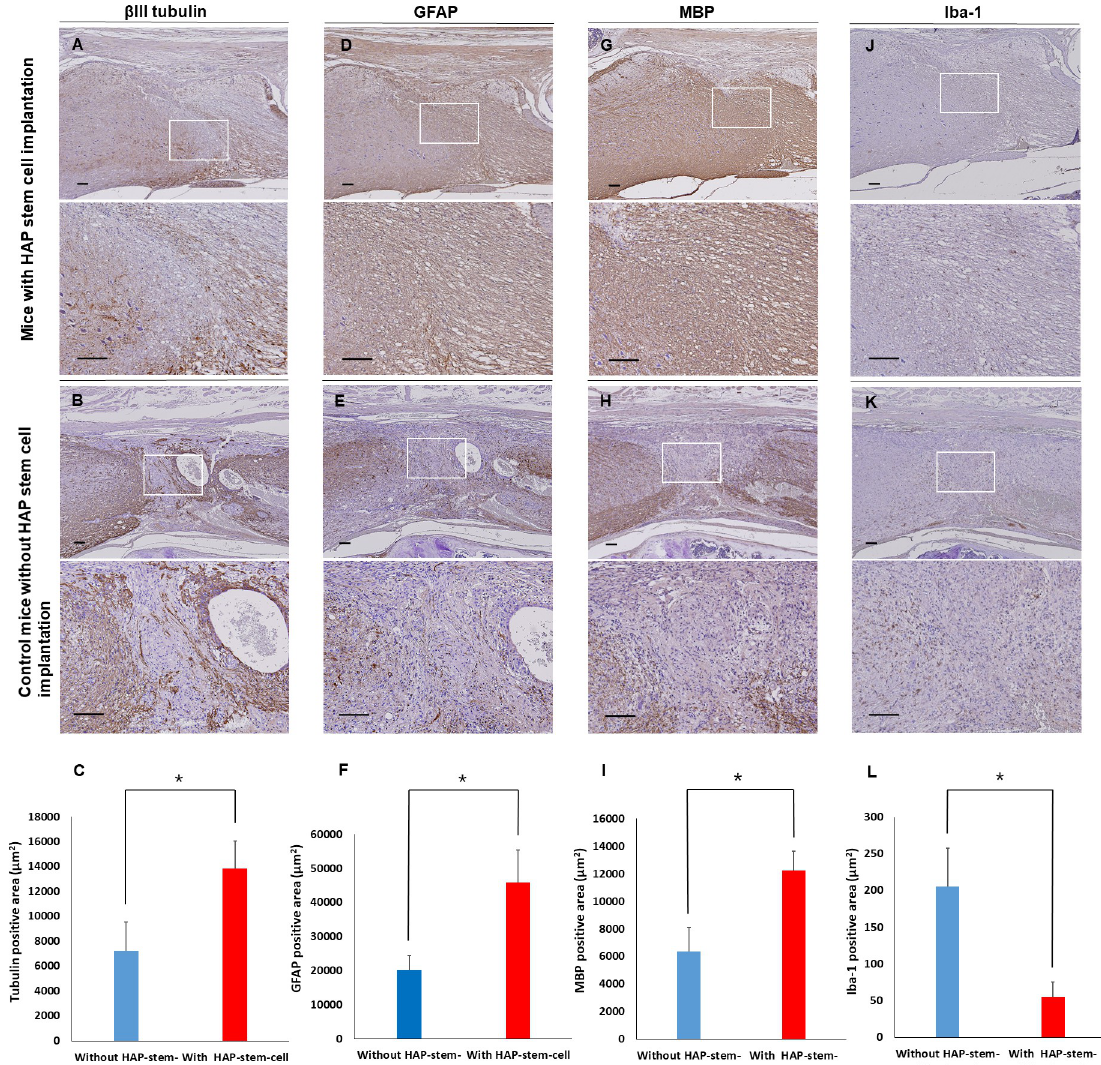
Fig 5. Immunostaining of the severed spinal cord implanted with HAP stem cells. (A, B) β III tubulin expression in the repaired spinal cord after HAP-stem-cell implantation and without implantation. (C) The β III tubulin-positive area in sagittal sections in mice with implanted HAP stem cells and control mice (mice with HAP-stem-cell implantation: n = 5; control mice without implantation: n = 5). � P < 0.05. (D, E) GFAP expression in the repaired spinal cord after HAP stem cell implantation and without implantation. (F) The GFAP- positive area in sagittal sections in the mice with implanted HAP stem cells and control mice (mice with HAP-stem-cell implantation: n = 5; control mice without implantation: n = 5). � P < 0.05. (G, H) MBP expression in the repaired spinal cord after HAP-stem-cell implantation and in the un-repaired spinal cord without implantation. (I) The MBP-positive area in sagittal sections in the mice with implanted HAP stem cells and control mice with an un-repaired spinal cord (mice with HAP-stem-cell implantation: n = 5; control mice without implantation: n = 5). � P < 0.05. (J, K) Iba-1 expression in the repaired spinal cord after HAP-stem-cell implantation and in the un-repaired spinal cord without implantation. (F) The Iba-1-positive area in sagittal sections in the mice with implanted HAP stem cells and control mice without HAP-stem-cell implantation (mice with HAP-stem-cell implantation: n = 5; control mice without implantation: n = 5). � P < 0.05. Upper panels = low-magnification. Bar = 100 μ m. Lower panels = high-magnification of white boxed area. Bar = 100 μ m. All images show sagittal sections with the spinal